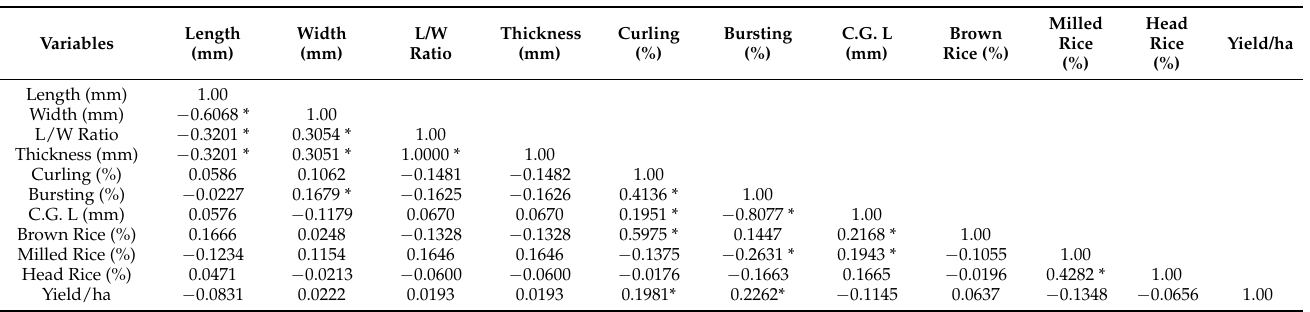
Table 6. Association of various morphological, quality and yield traits of hybrid rice in adaptability trials 2021.